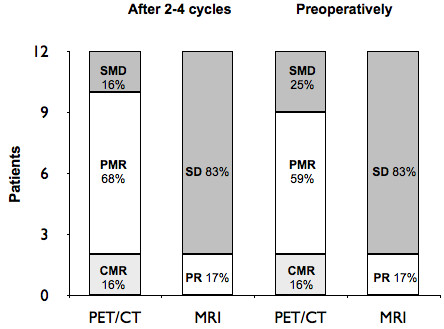
Assessment of response to preoperative chemotherapy; determined by 18FDG PET/CT and MRI scanning. PET/CT response was assessed according to EORTC guidelines, SMD = 2, PMR = 8, CMR = 2 after 2–4 cycles; SMD = 3, PMR = 7, CMR = 2 preoperatively. MRI was assessed according to RECIST criteria, SD = 10, PR = 2 both after 2–4 cycles and preoperatively.